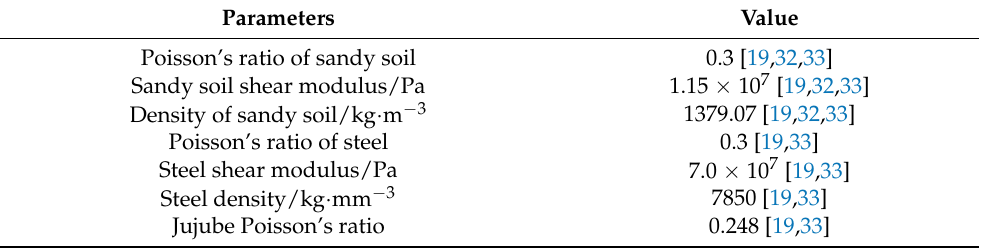
Table 1. Simulation contact parameter table.